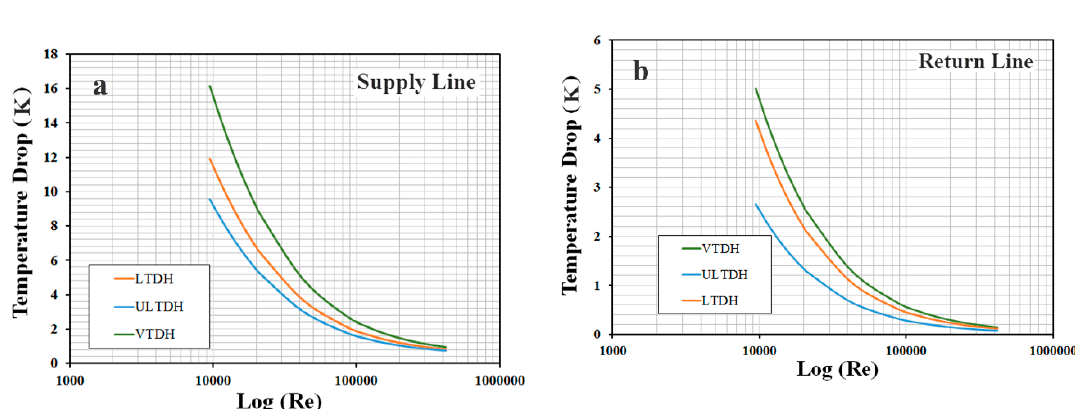
Figure 10. The effect of Reynolds number on the level of temperature drop over the entire pipeline in each case. ( a ) supply lines; ( b ) return lines.